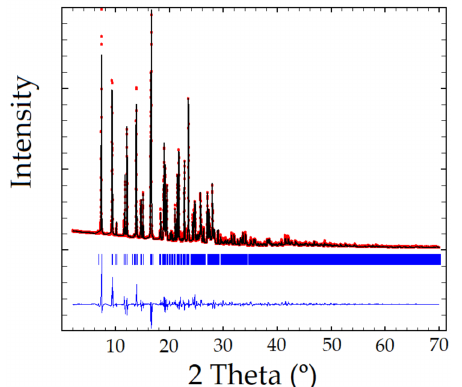
Figure 2. Rietveld plot of the Sildenafil–resorcinol cocrystal, R wp = 8.61%, Chi 2 = 107. Experimental powder XRD profile in red, the calculated one in black, and the di ff erence in blue. Peak positions (in blue) are indicated using tick